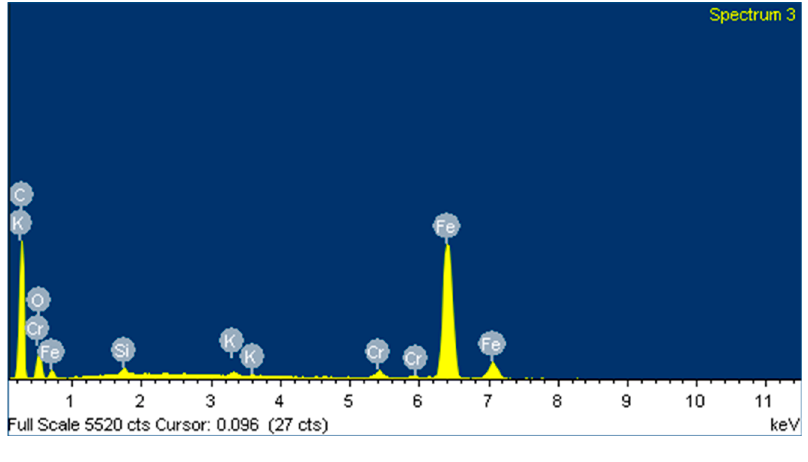
Figure 23. EDS spectrum of a tested area of the disc.